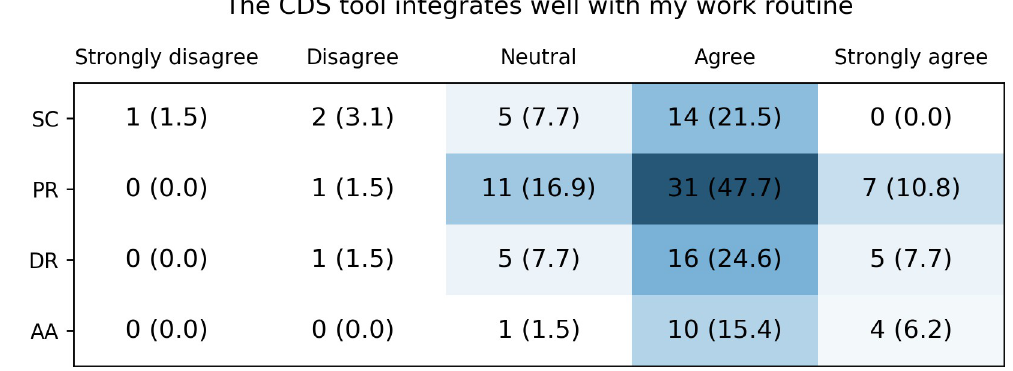
Fig 7. Healthcare providers’ rating of workflow integration of the different CDS tools. SC: Safety Code cards, PR: printed reports, DR: digital reports, AA: automatic alerts.